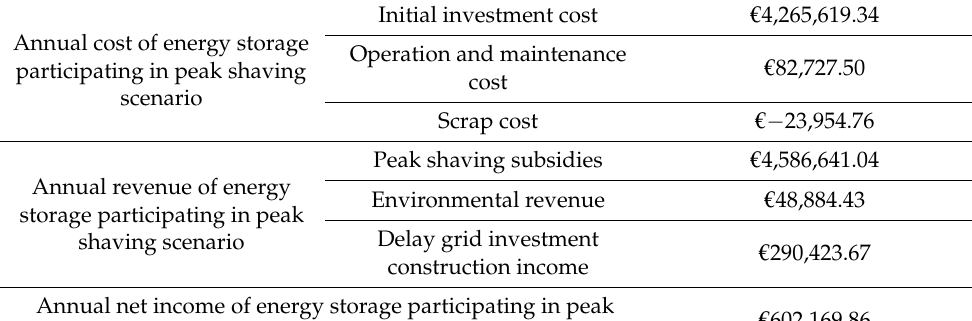
Table 6. Annual costs and benefits of energy storage participating in peak shaving